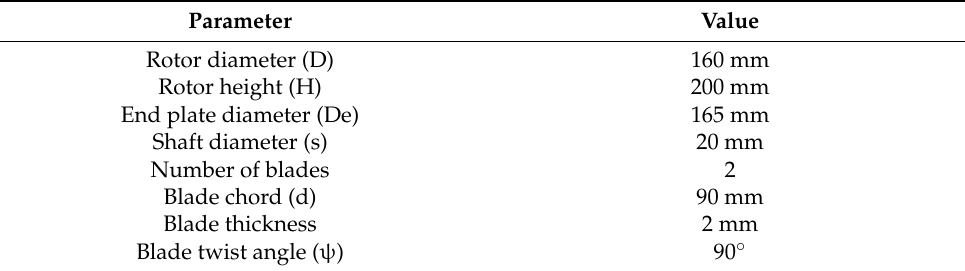
Table 1. Geometrical parameters of Savonius rotor.